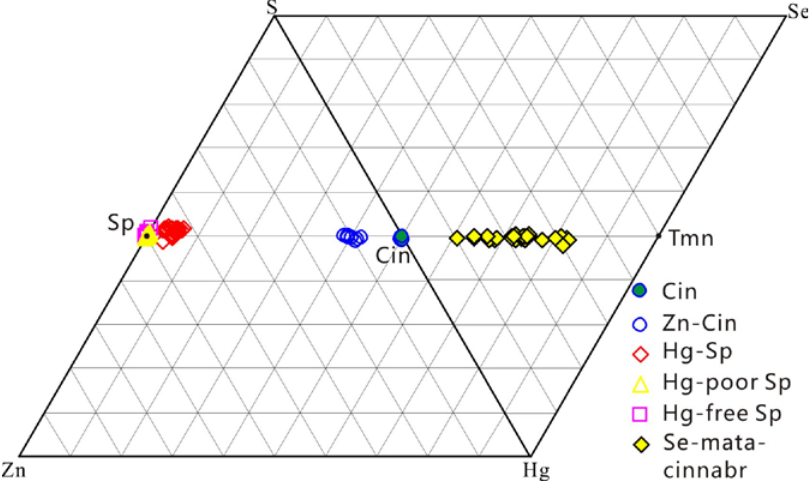
Figure 13. The Zn–Hg–S and Hg–Se–S series minerals of the Chashula and Dongping deposits.